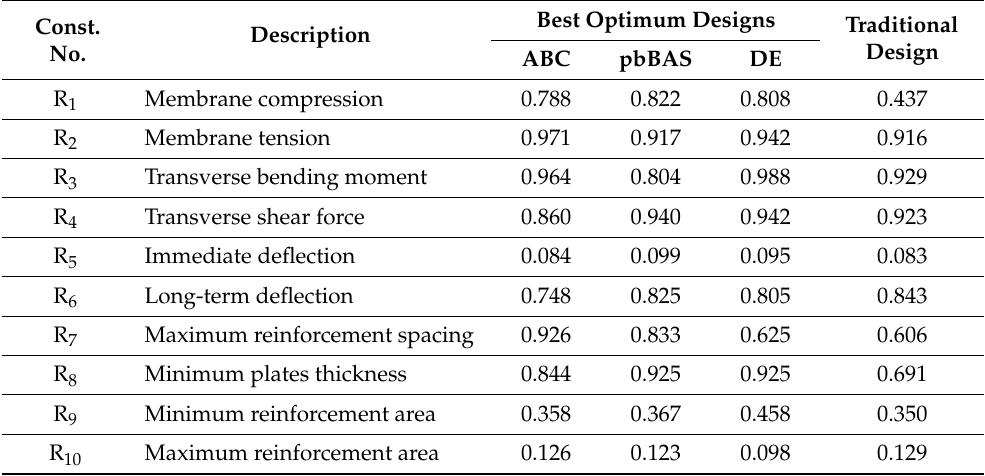
Table 18. Folded plates constraints the maximum demand capacity ratios in the optimum designs achieved by each metaheuristic algorithm for the V-type folded plate roof building. Const.